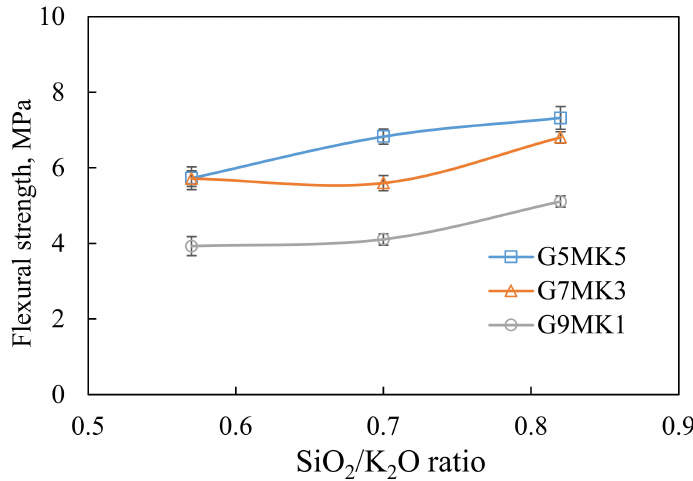
Figure 6. Flexural strength of geopolymer slurry after sintering at 1200 ◦